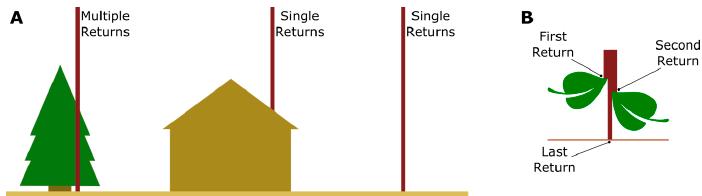
Figure 1. Aerial LiDAR single and multi-return pulses: ( A ) Example of single and multiple returns; and ( B ) Example of multi-return, portions of the LiDAR pulse being blocked by physical objects (i.e., tree leaves), while the remainder continues. (Note: elements in the images are not to scale. Aerial LiDAR is collected from above in aviation vehicles).